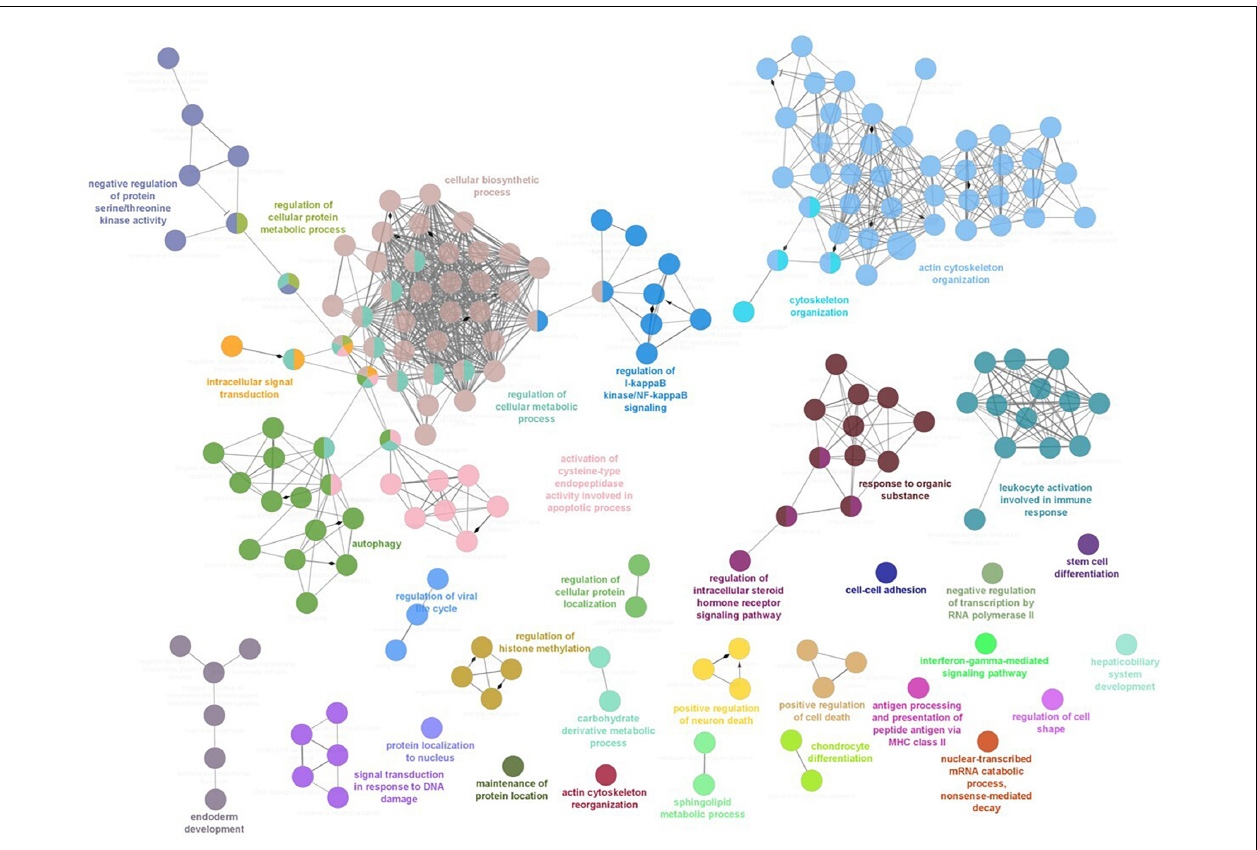
FIGURE 2 | Functional enrichment network analysis for biological processes based on the total number of differential expressed genes (DEGs) in head kidney of Atlantic salmon smolts fed the MPLE-supplemented diet. Each node represents a specific enriched biological process from the total number of DEGs. Each color indicates a cluster of closely related biological processes. The lines into the cluster indicated a closed relationship between biological processes. The details of each node are shown in Supplementary Table 2